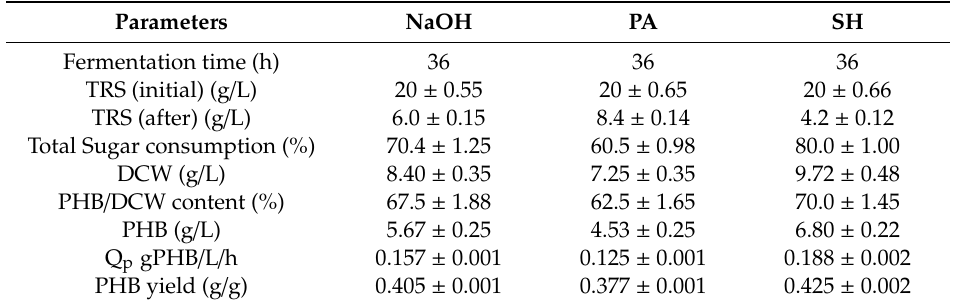
Table 3. Sugar consumption, R. eutropha growth and PHB production kinetics parameters using